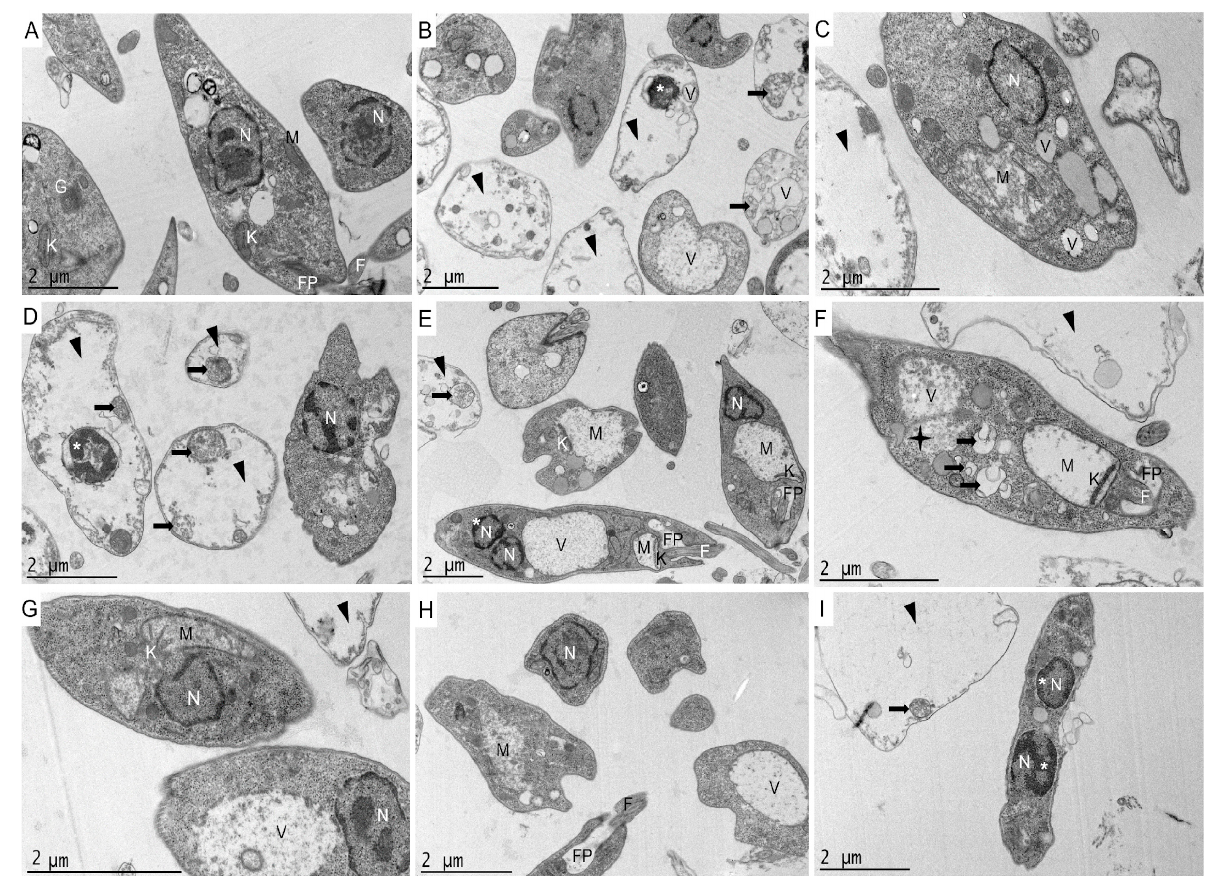
Figure 5. Transmission electron microscopy of L. amazonensis promastigotes after 24 h of incubation at the IC 90 levels of compounds 2 – 4 . The control parasite (image ( A )) showed its characteristic elongated body and normal morphology of the nucleus (N), mitochondrion (M), kinetoplast (K), Golgi (G), flagellum (F) and flagellar pocket (FP). Similar ultrastructural damage can be observed in L. amazonensis promastigotes after incubation with gongolarone B (images ( B , C )), 6 Z -1’-methoxyamentadione (images ( D – F )) and 1’-methoxyamentadione (images ( G – I )). These compounds caused mitochondrial expansion (M), chromatin condensation in the nucleus (*), intense vacuolization (v), the formation of some autophagy vacuoles (black arrows) and alterations in the morphology of the flagellar pocket (FP). In addition, abundant parasite debris (black triangles) can be observed, confirming the antikinetoplastid activity of these compounds.